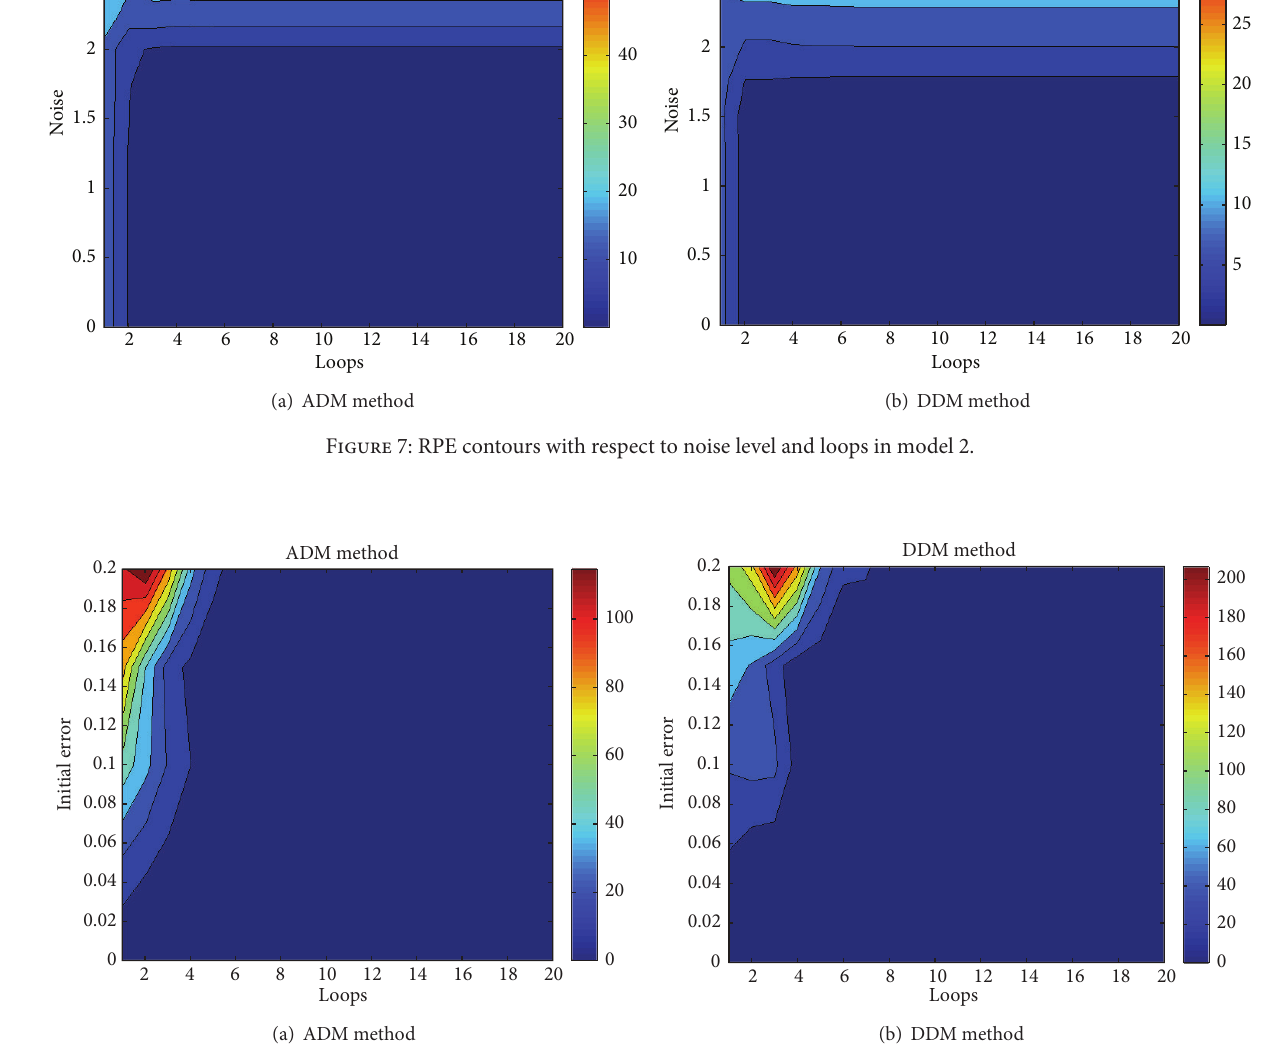
Figure 8: RPE contours with respect to initial error and loops in model